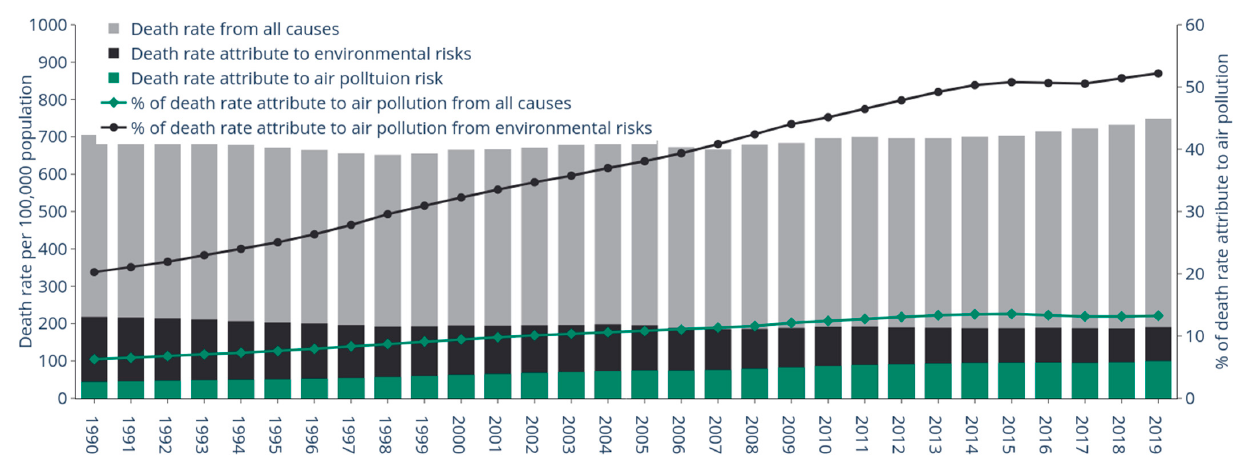
Figure 12. Death rates in China from 1990 to 2019 (Original data source: GDB database).